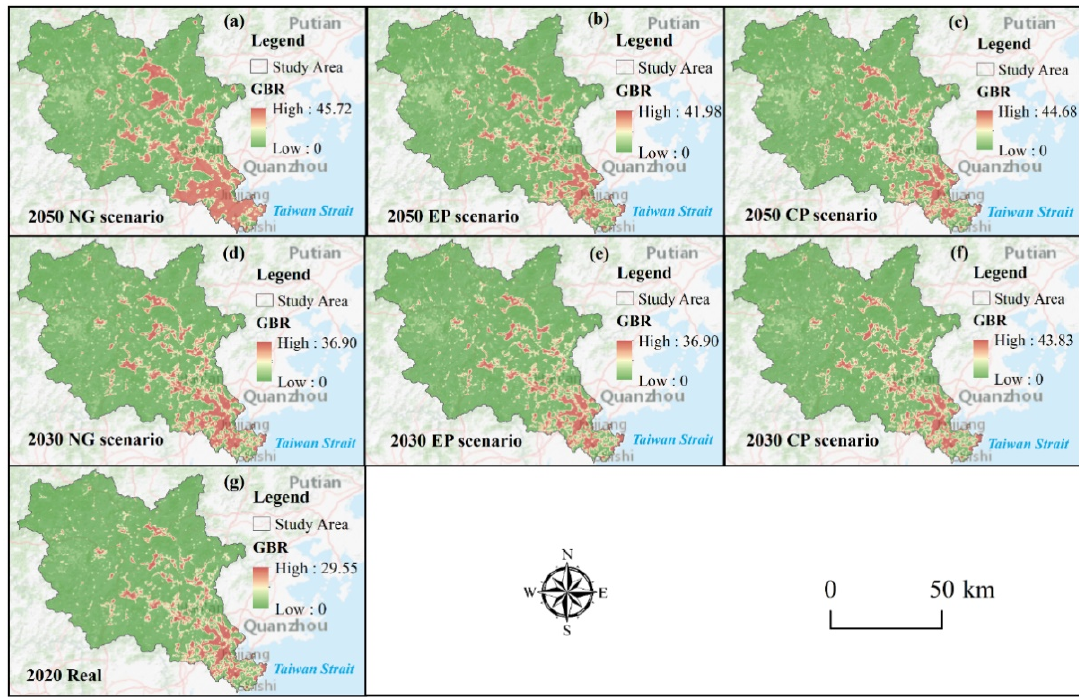
Figure 8. Spatial distribution of future general budget revenue per unit area (GBR, billion yuan/100 m 2 ) in Jinjiang Basin. NG, EP, and CP scenarios represent natural growth, ecological protection, and cropland protection scenarios, respectively. Subfigures ( a ), ( b ) and ( c ) are the GBRs under NG, EP and CP scenarios in 2050, respectively. Subfigures ( d ), ( e ) and ( f ) are the GBRs under NG, EP and CP scenarios in 2030, respectively. Subfigures g is the GBR in